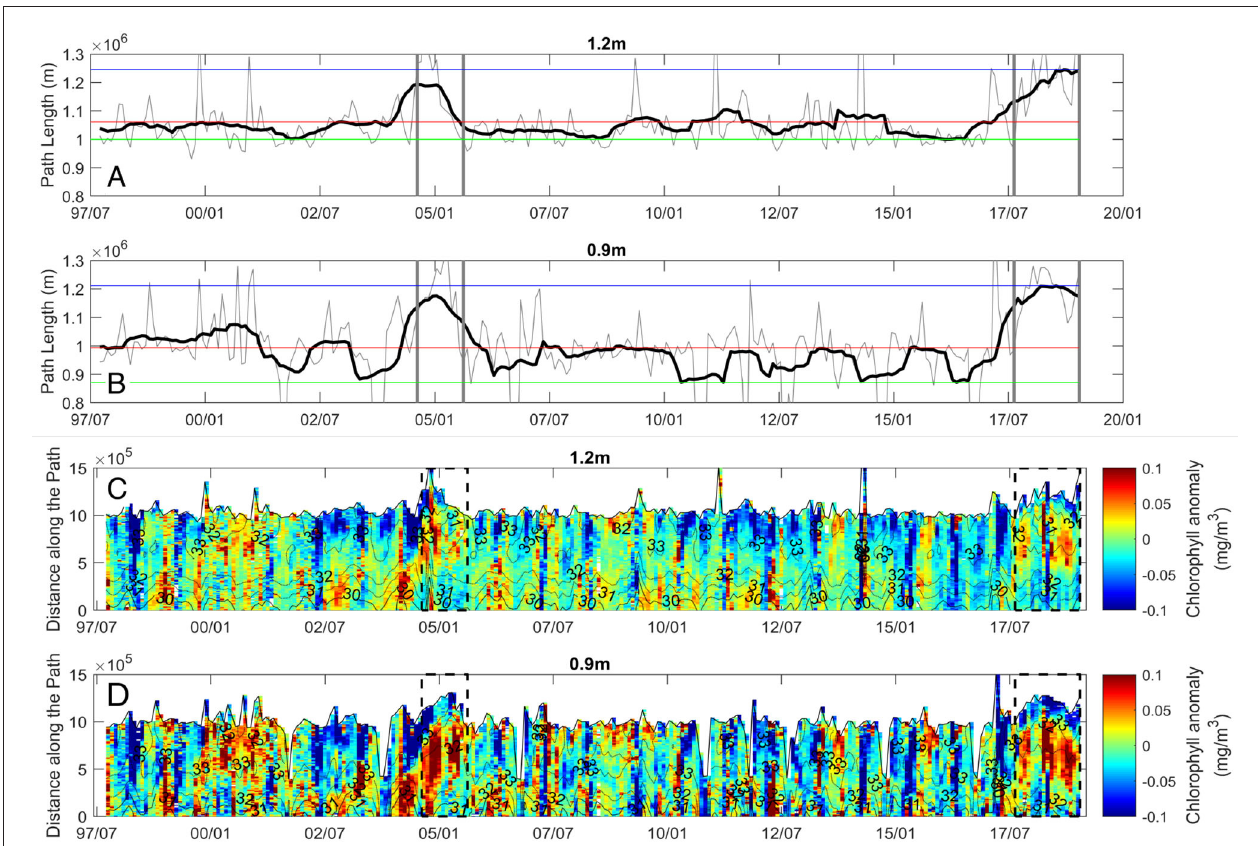
FIGURE 3 | The Kuroshio path lengths within the Kuroshio region (131–140 ◦ E) defined in the Figure 1A as a blue box with different SSH values for the Kuroshio definition, for (A) 1.2, and (B) 0.9 m of SSH values. Black lines show the path lengths after 13-month running average of the monthly data, which are shown as the gray lines. The periods indicated with the gray lines represent the large meander periods. Red line indicates the average path length, and blue line the maximum and green line the minimum path length. Chlorophyll anomaly in color as a function of time and path length (distance along the Kuroshio path) with different definitions of the Kuroshio axis with the SSH values for (C) 1.2 and (D) 0.9 m. Black dashed line indicates the large meander periods. Gray shaded thin line indicates the Path length. The contours are avergae